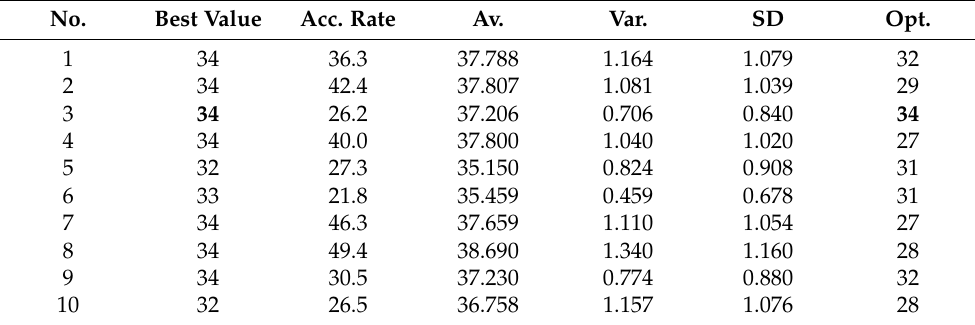
Table 5. Comparison of the experimental results obtained using neal and the optimal solution. No. Best Value Acc. Rate